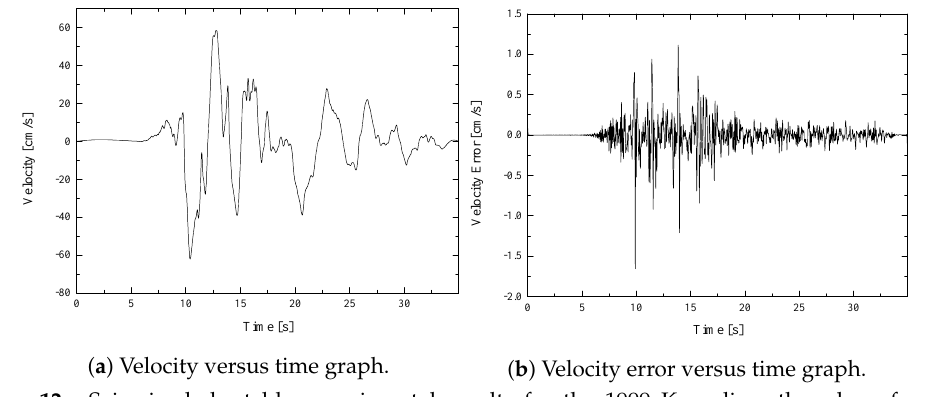
Figure 12. Seismic shake table experimental results for the 1999 Kocaeli earthquake reference seismic waves.